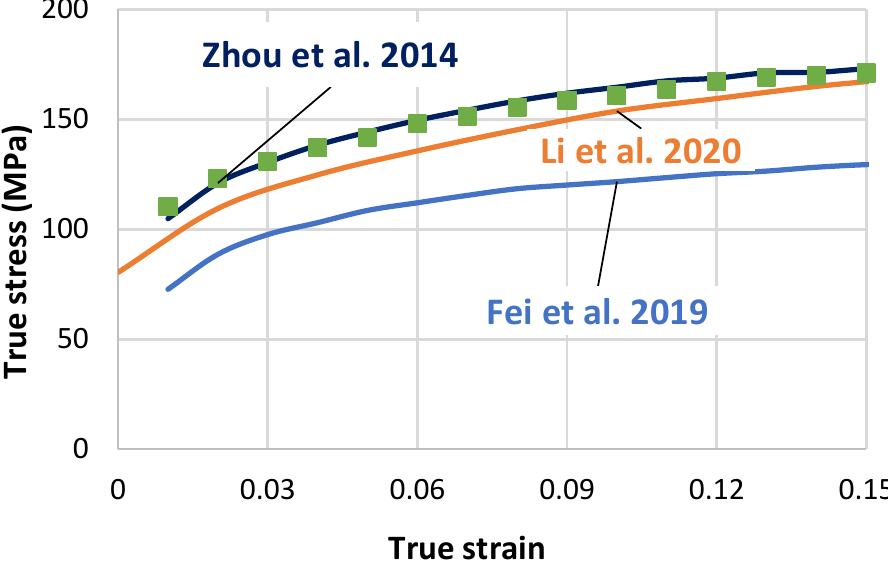
Figure 11. Comparison between literature [11,15,16] and experimental flow curve for the temperature of 800 ◦ C and the strain rate of 0.1 s − 1 .